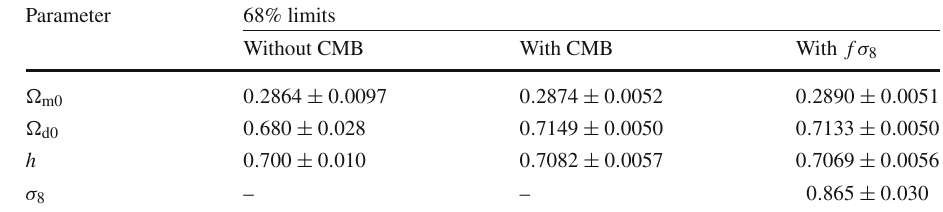
Table 5 The best fit values of free parameters and 1 σ uncertainties using different data sets for (cid:2) CDM model in non-flat universe